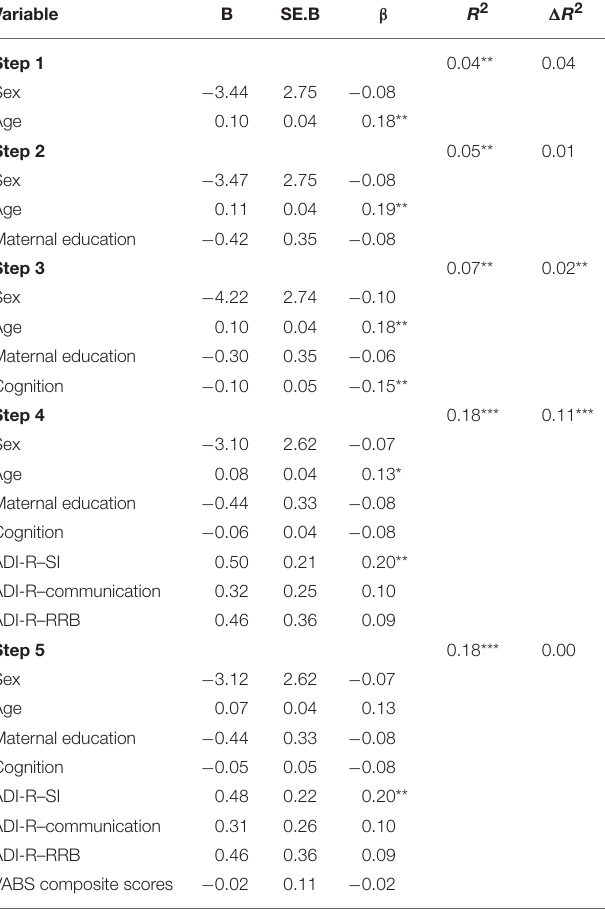
TABLE 8 | Linear regression model for the CPRS anxiety scores. Variable